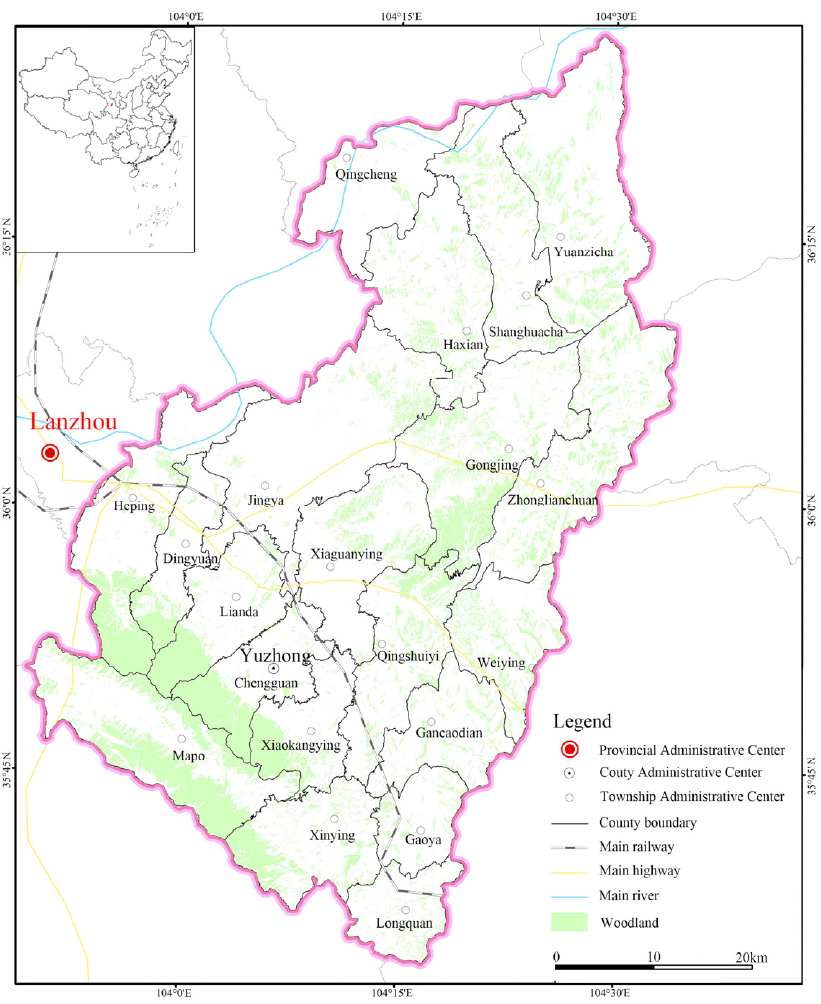
Figure 1. Location of Yuzhong County. At the end of 2019, Yuzhong County had jurisdiction over 20 townships with a reg- istered population of 461.10 × 10 3 , among which the rural population was 351.90 × 10 3